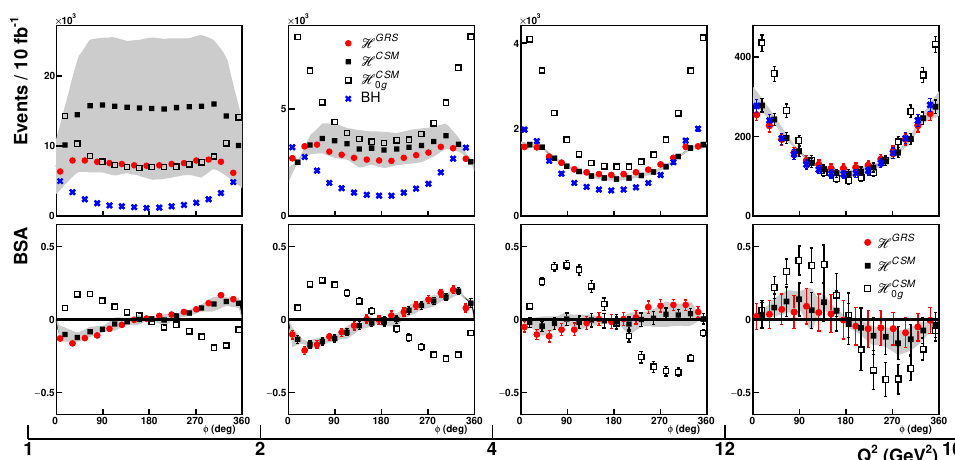
Figure 14. Upper band: number of events assessed as a function of φ for different bin in Q 2 . The blue crosses correspond to the Bethe–Heitler signal only, the black square—to the theoretically complete model of ref. [58] with a CSM-based forward limit. The open square correspond to the same model but with gluons set to zero in the CFF. The red circles correspond to a phenomenological model with the GRS PDF [155] as an input for the forward limit. The grey band corresponds to the uncertainty of the CSM model associated with the choice of the initial evolution scale. Lower band: associated beam spin asymmetries. The sign flip is visible with the model from ref. [58]. Figure from ref.